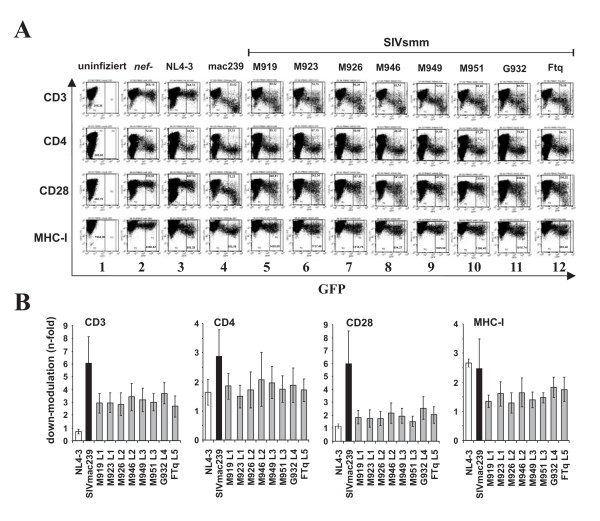
Modulation of receptor expressed by human PBMC by SIVsmm nef alleles. (A) PBMCs (panels A-D) were transduced with HIV-1 NL4-3 constructs coexpressing the indicated nef alleles and GFP and assayed for surface expression of CD4, CD3, CD28 and MHC-I. The ranges of eGFP expression used to calculate receptor modulation are indicated. (B) Quantitative assessment of SIVsmm Nef-mediated down-modulation of the indicated cellular receptors. The animal specifications and SIVsmm lineages are indicated and the activities obtained using the SIVmac Nef are shown for comparison. Values give averages ± SD derived from three independent experiments. The asterisks denote a statistical significance (P < 0.05) between SIVmac239 and SIVsmm Nef activity. All SIV nef alleles were significantly (P < 0.001) more active than that of HIV-1 in modulating CD3, whereas the HIV-1 nef was more active (P < 0.05) than all SIVsmm nefs in down-regulation of MHC-I.